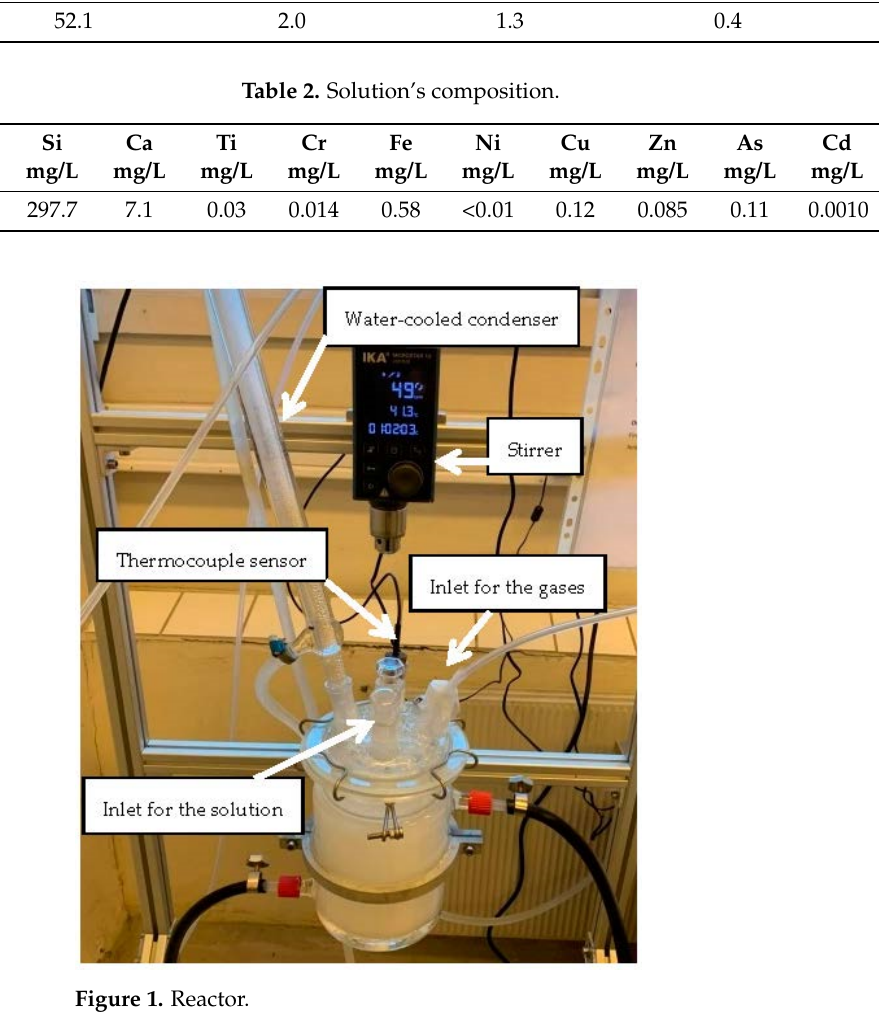
Table 3. Experimental plan: Gas composition and temperatures.